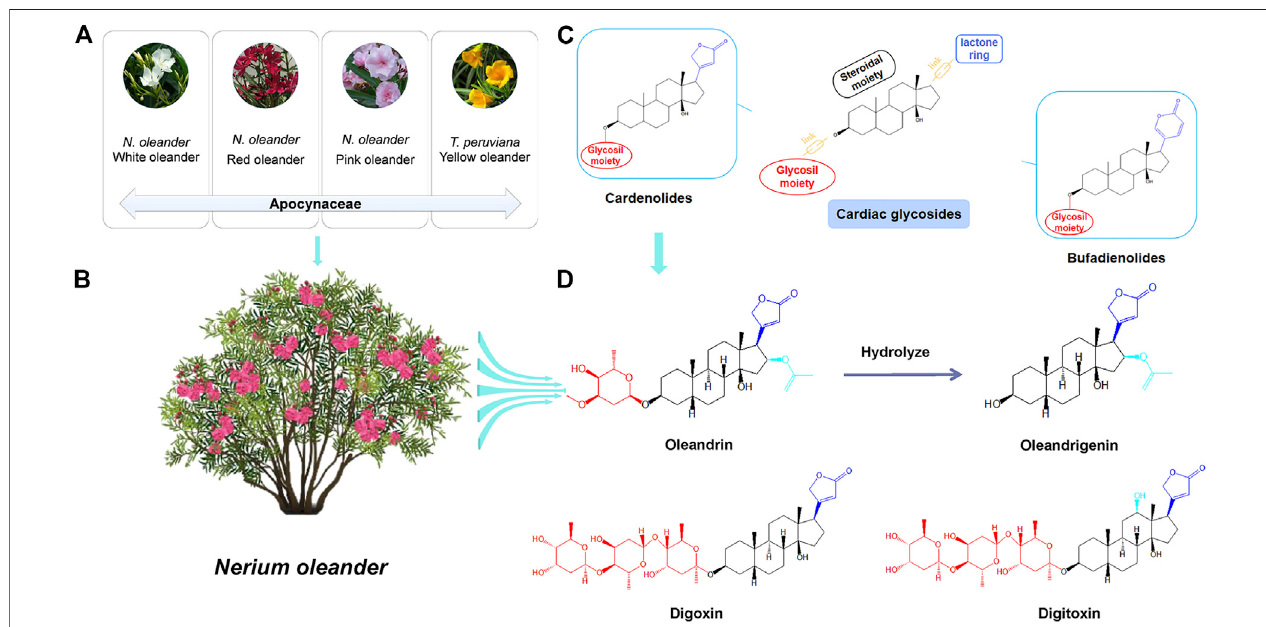
FIGURE 1 | Natural sources and structural properties of oleandrin. (A) Categories of plants commonly known as “ oleander. ” (B) The main sources of oleandrin: Nerium oleander . (C) Classi fi cation of cardiac glycosides (CGs). (D) The chemical structure of oleandrin and its hydrolysate oleandrigenin and other structure of typical